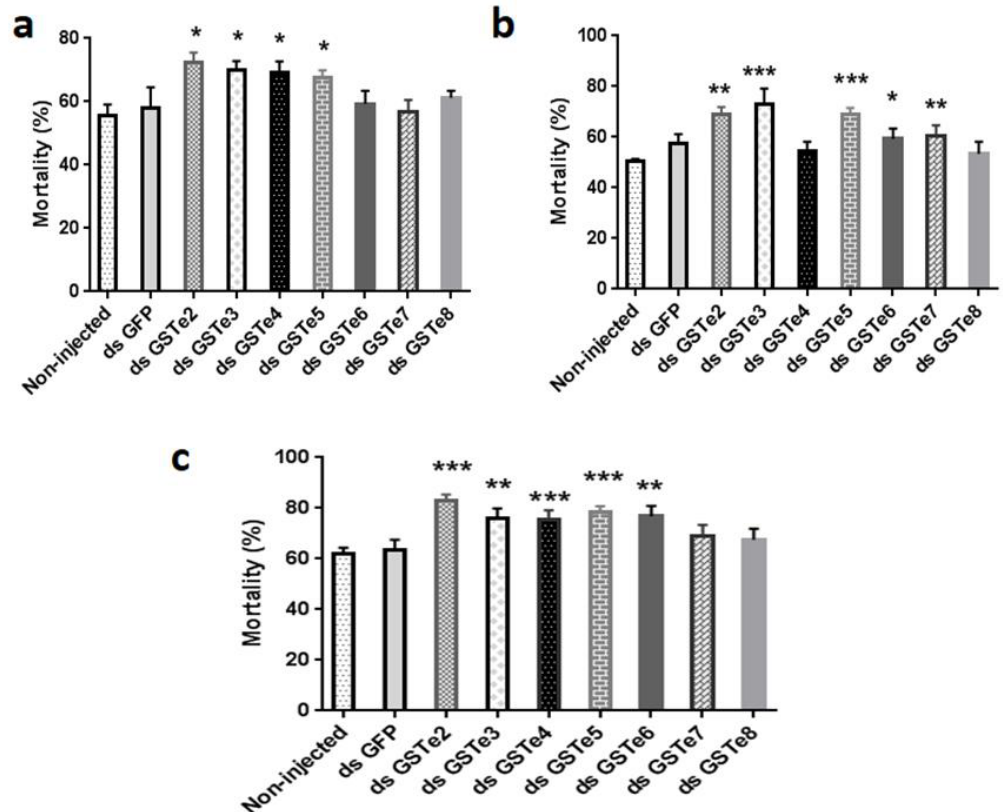
Figure 4. GSTe knockdown increases susceptibility to insecticides; bioassay result of mosquitoes after injection and exposure to ( a ) permethrin, ( b ) deltametrin and ( c ) DDT. * = p < 0.05, ** = p < 0.01, and *** = p <